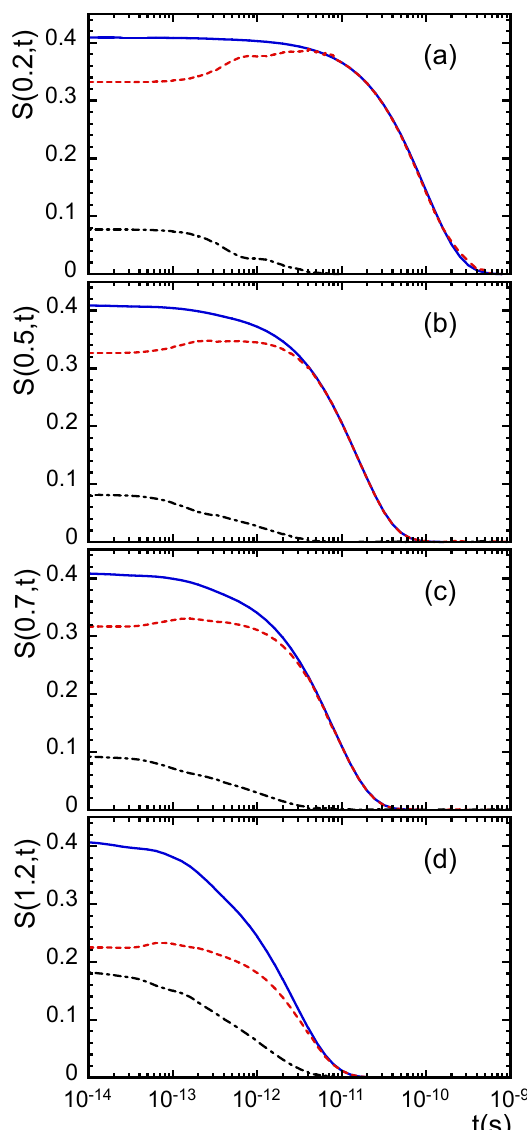
Fig. 6. Coherent dynamic structure factor S ( Q , t ) (dashed- dotted lines) corresponding to D 0 O, its self part 𝑆 rstu (𝑄,𝑡) (blue continuous line), and the distinct part with opposite sign - 𝑆 v‘rh (𝑄,𝑡) (red dashed line) for Q = 0.2 Å 34 (a); Q = 0.5 Å 34 (b); Q = 0.7 Å 34 (c) and Q = 1.2 Å 34 (d).